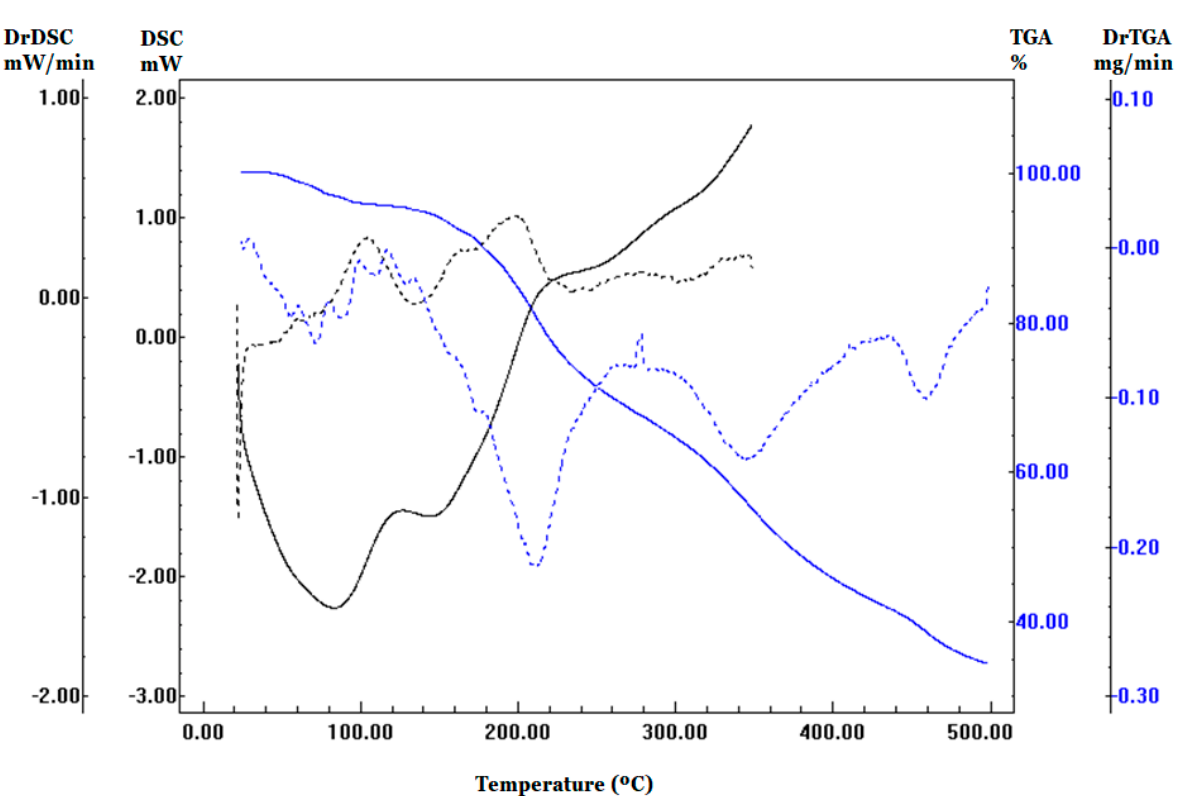
Figure 1. DSC (black profiles) and TGA (blue profiles) analyses of pollen. Dashed lines refer to the second derivates.